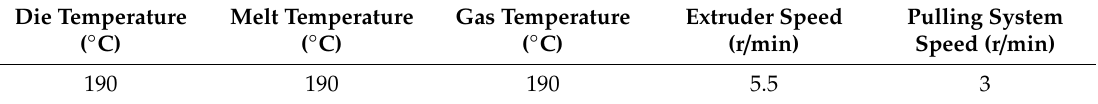
Table 2. Processing parameters.